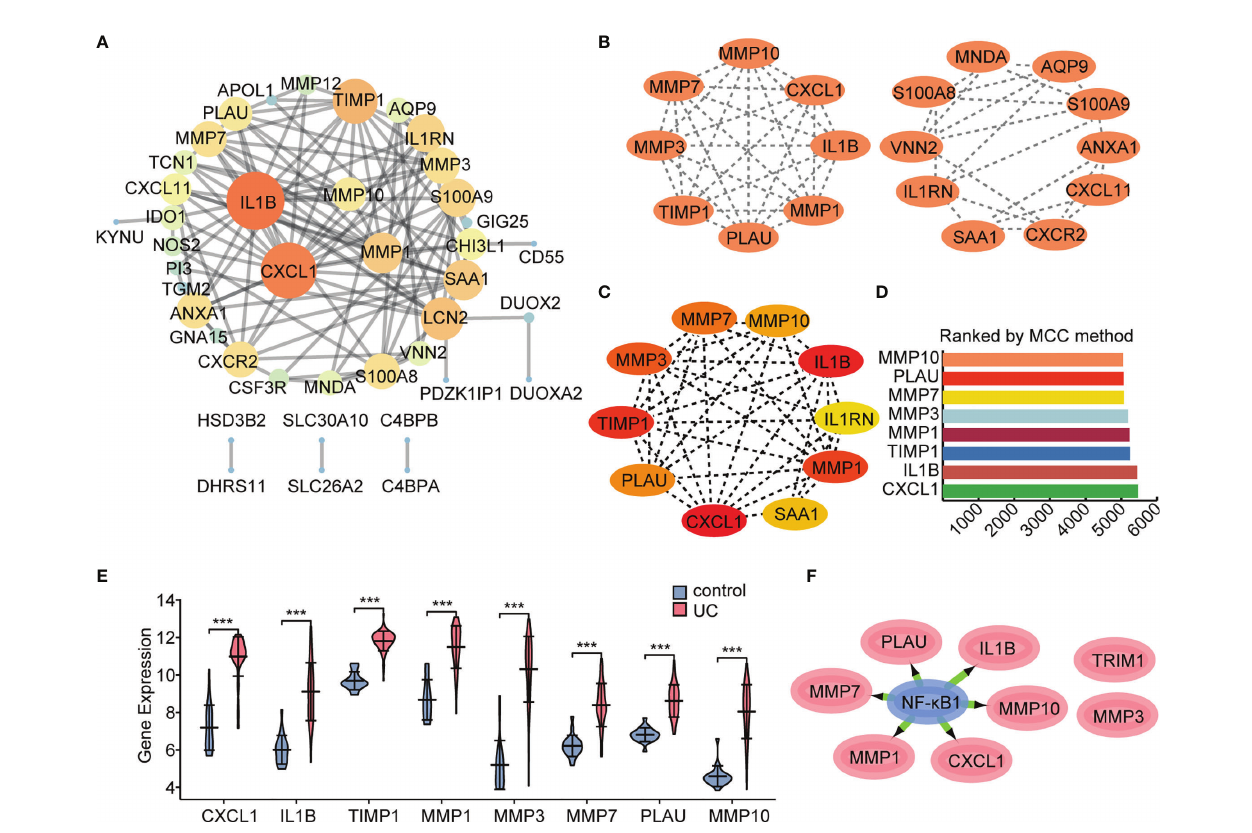
FIGURE 6 | Protein interaction network. The network was constructed and visualized using Cytoscape software. (A) PPI network. The nodes represent proteins, the edges represent their interaction. (B) MCODE sub-network, including cluster 1 and cluster 2. (C, D) Cytohubba-MCC was used to identify hub genes in the network. (E) Differential gene expression analysis in GSE92415 cohort. (F) The master regulator predicted by the iRegulon tool is highlighted in blue, and target genes are in pink. *** P <